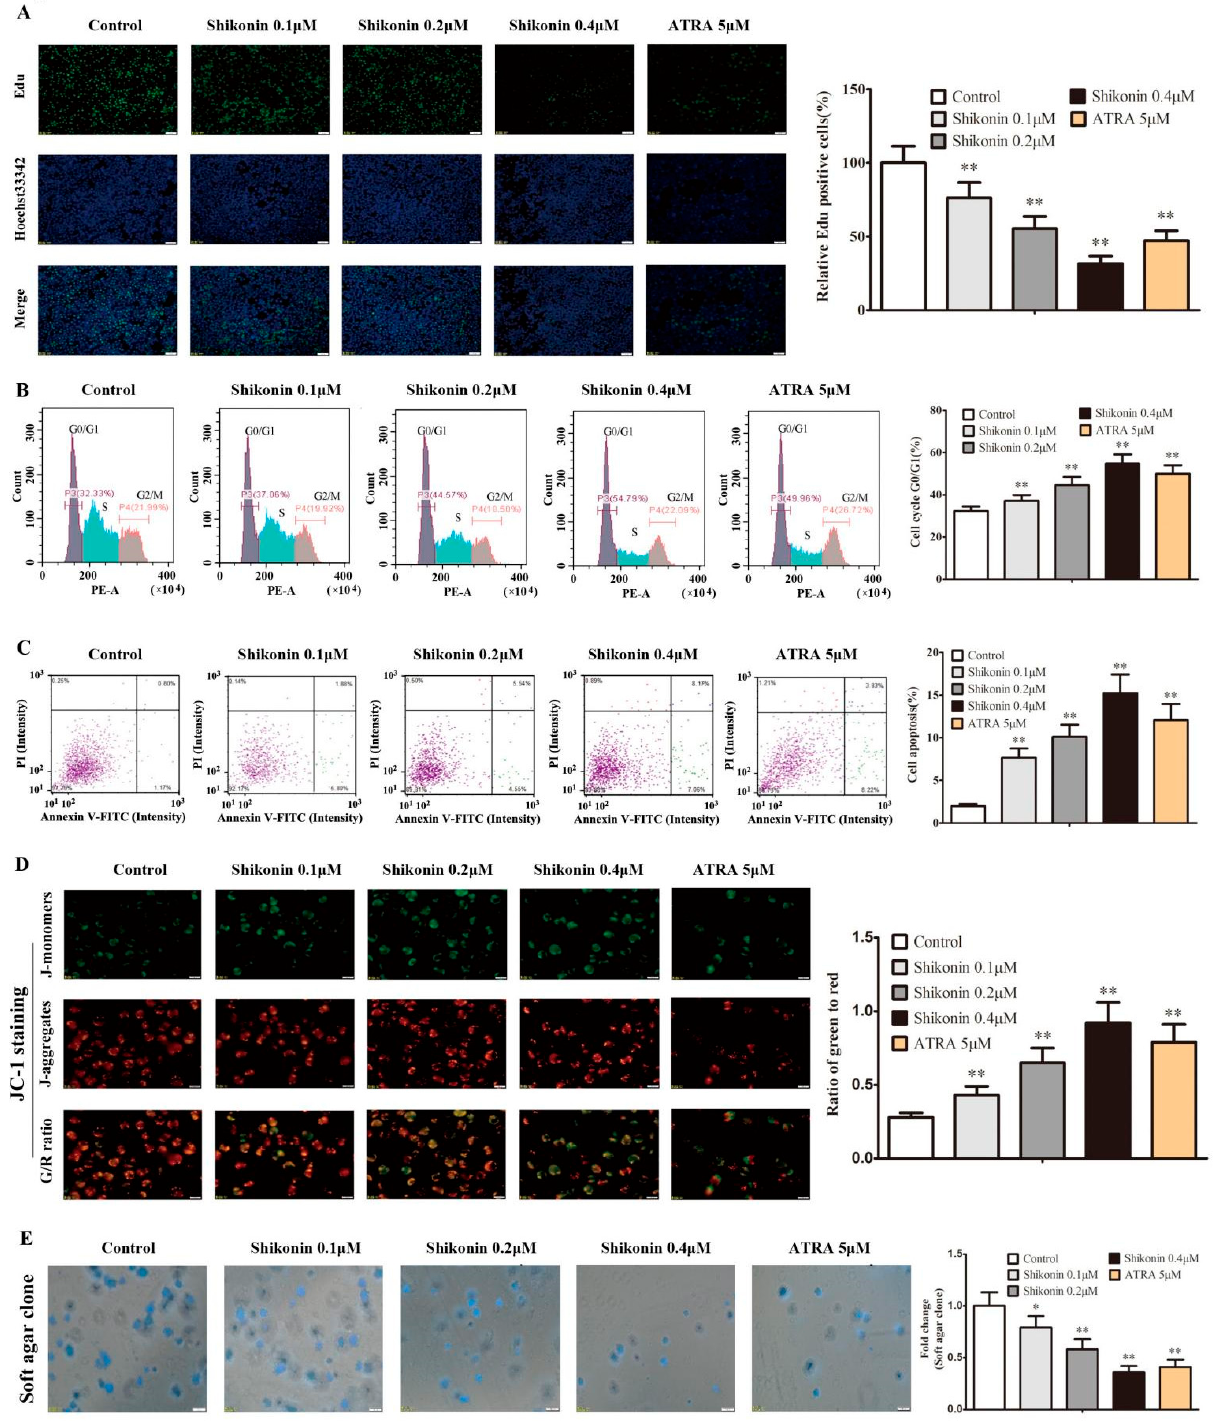
Figure 6. Shikonin-differentiated HL-60 cells gradually lose the ability of cell proliferation and self-renewal. HL-60 cells were treated with shikonin for 10 d. ( A ) Cell proliferation was detected by EdU incorporation. ( B ) The cell cycle was detected by PI staining using flow cytometry. ( C ) Cell apoptosis was detected by Annexin V-FITC/PI staining using flow cytometry. ( D ) The mitochondrial membrane potential (MMP) was detected by JC-1 staining, which forms J-monomers with green fluorescence to label the low MMP and J-aggregates with red fluorescence to label the high MMP. ( E ) Cell self-renewal was detected by soft agar clone formation. The data were presented as the mean ± SD (n = 3). * p < 0.05; ** p < 0.01 compared to the untreated control.